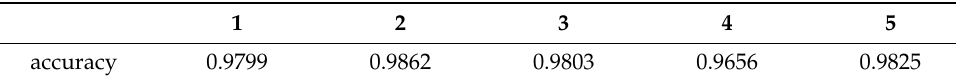
Table 11. Accuracy of 5-fold crossover validation.